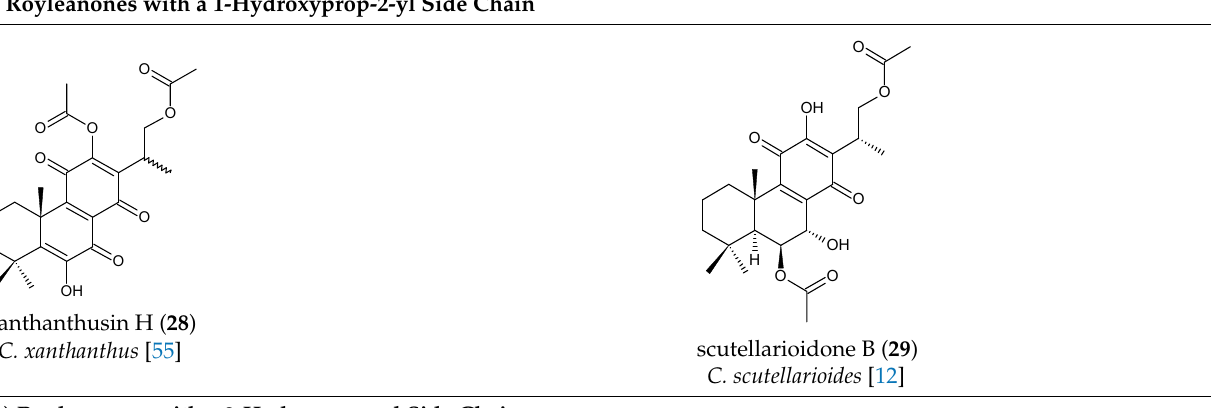
(c) Royleanones with a 2-Hydroxypropyl Side Chain